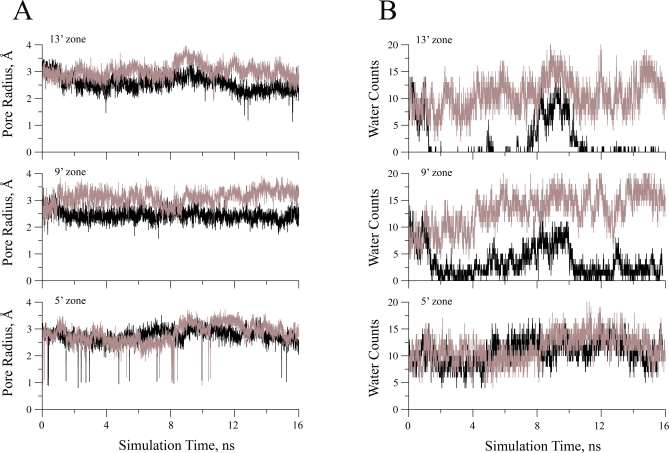
Pore Radius and Number of Water Molecules in Contiguous 6 Å Thick Zones Centered at TMD2 Positions 5′, 9′, and 13′ Plotted against Simulation TimeBlack traces represent the simulation at −100 mV, and the brown traces represent the simulation at −200 mV.